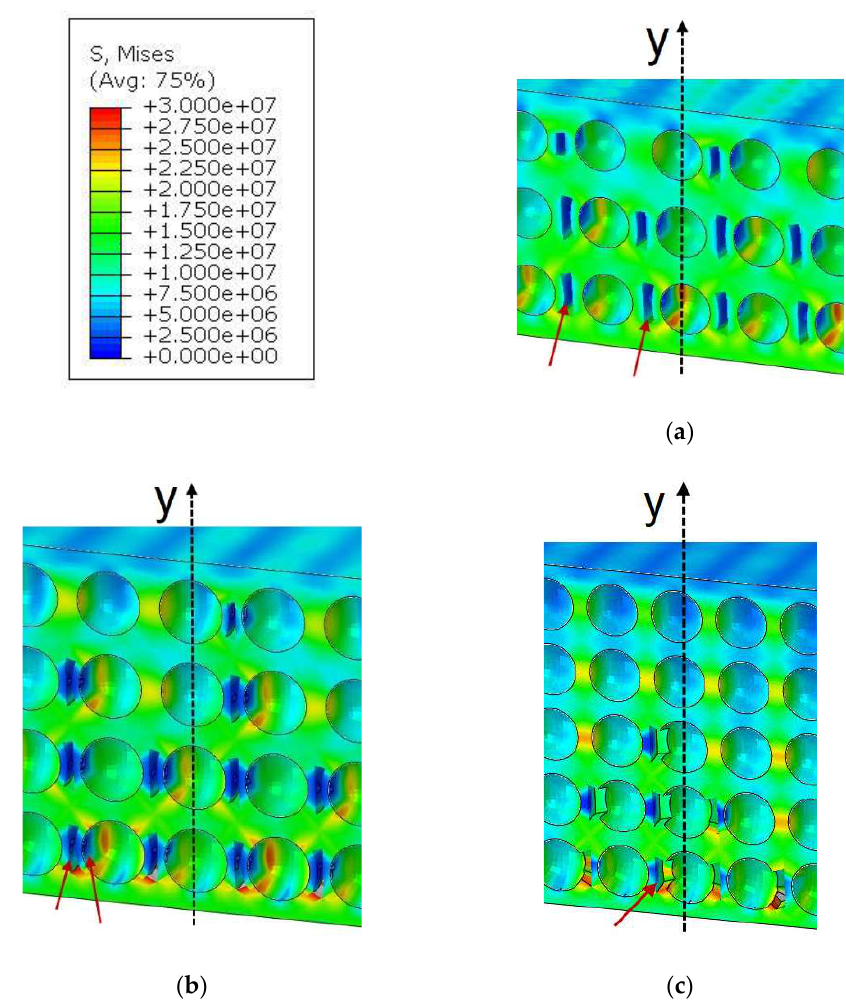
Figure 15. Tensile damage of the matrix in the PL by vertical microcracking: ( a ) model_1 (fi = 0.25 mm); ( b ) model_2 (fi = 0.19 mm); and ( c ) model_3 (fi = 0.15 mm).